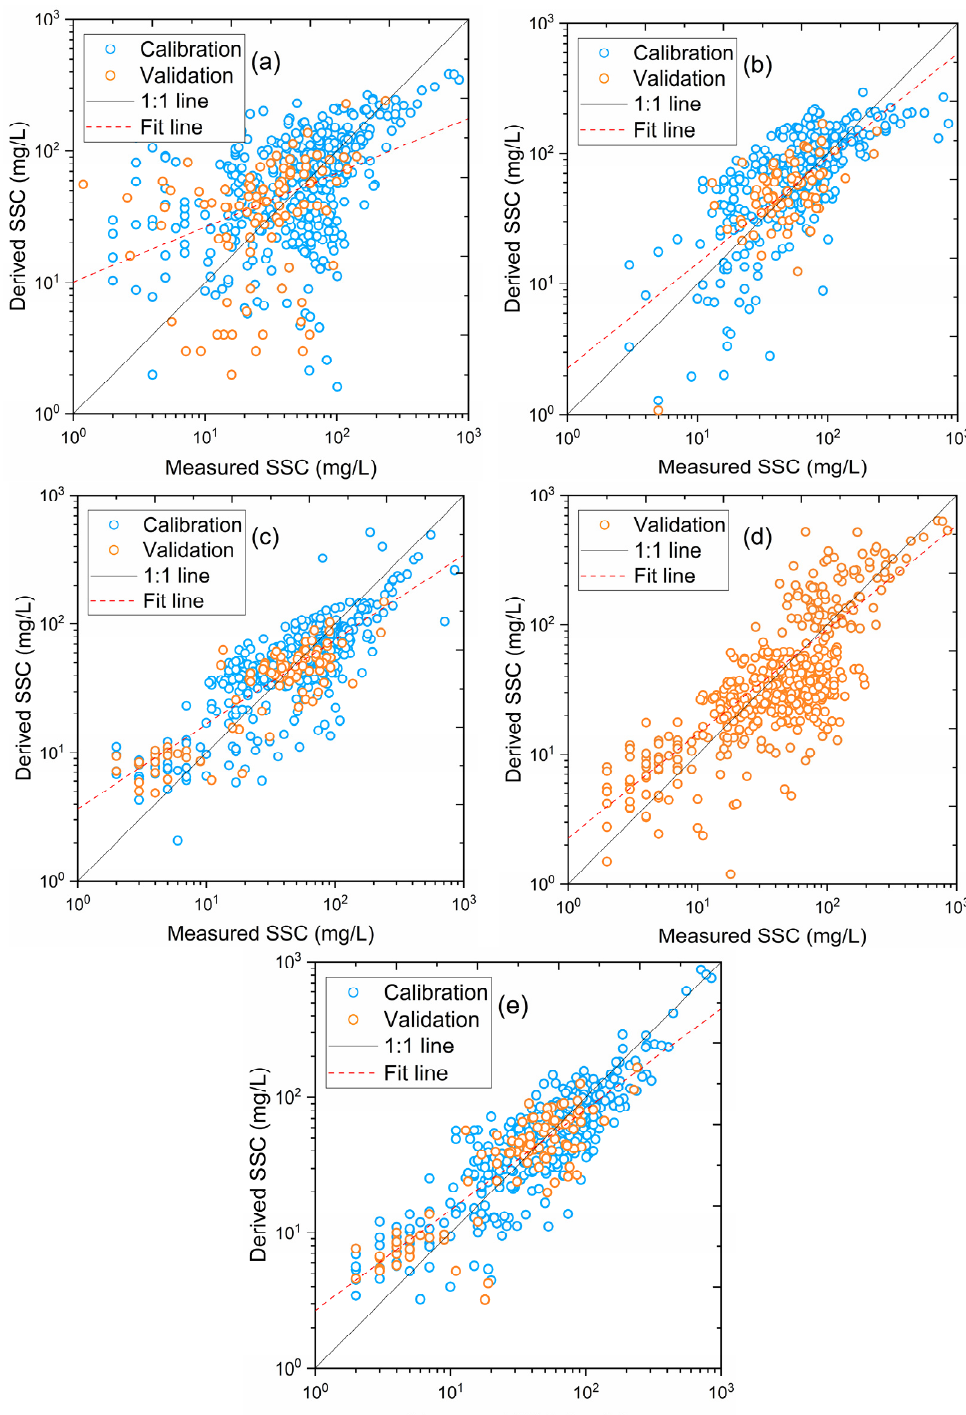
Figure 12. Performance evaluation of multiple SSC retrieval methods shown alongside our model applied to simulated MSI spectral bands. The models described are the ( a ) Cai model, ( b ) Hou model, ( c ) Yue model, ( d ) SOLID, and ( e ) our model.